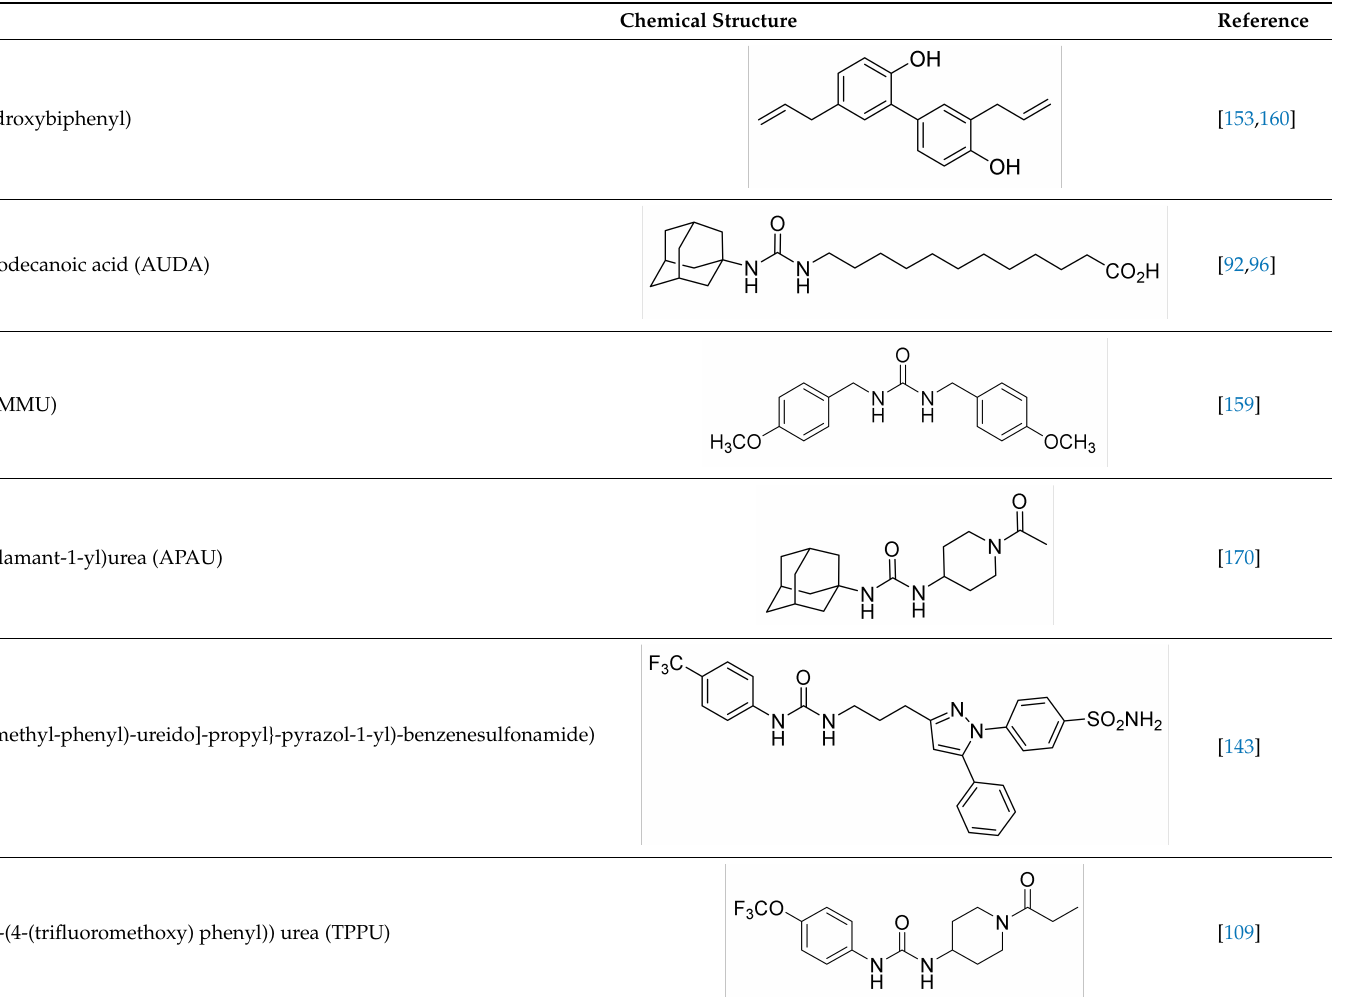
Table 2. Compounds tested in Parkinson’s disease